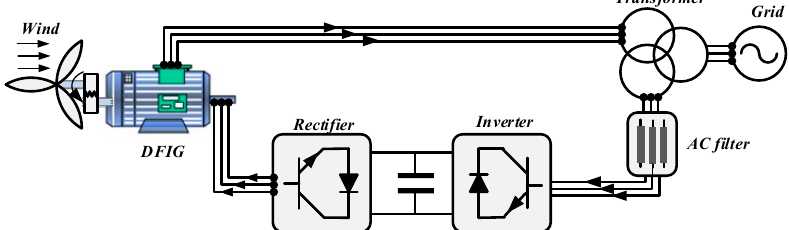
Figure 1. Typical wind energy system (WES) structure based on the doubly-fed induction generator (DFIG).